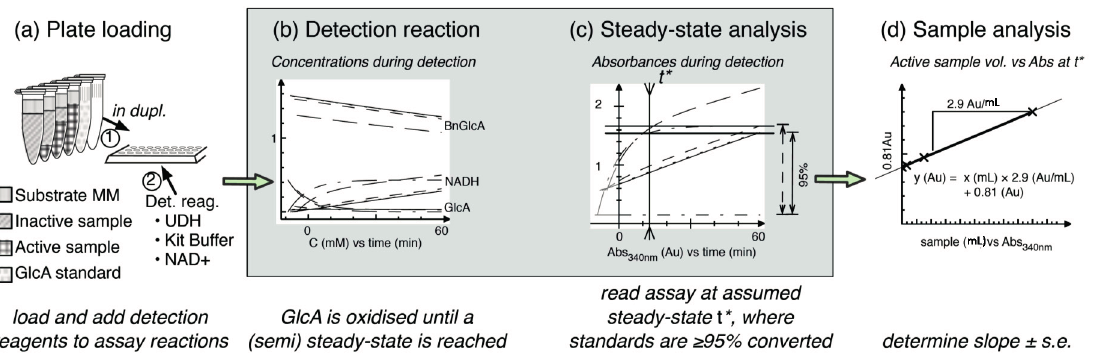
Figure 3. Summary of the spectrophotometric assay. After the enzymatic reaction the samples are; ( a ) loaded together with controls and standards into a 96-well microplate and supplemented with detection reagents; In the detection reaction ( b ) GlcA released during the enzymatic reaction is oxidized while BnGlcA is continuously hydrolyzing to release additional GlcA. A (semi) steady-state is eventually reached at time t ; ( c ) The detection reaction is assumed to be at steady-state when the included standard(s) have reached 95% conversion (time t *); ( d ) The slope of sample amount vs. absorbance at t * is